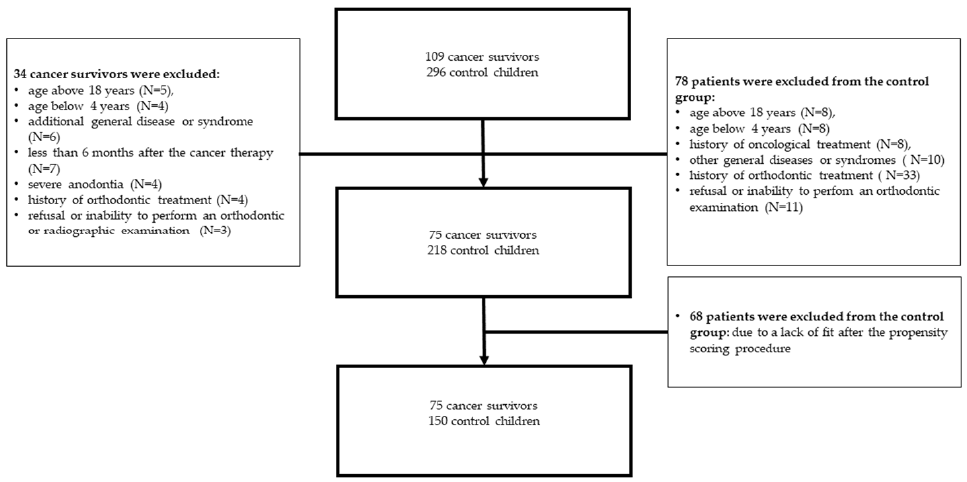
Figure 1. Diagram of inclusion and exclusion criteria for both groups.